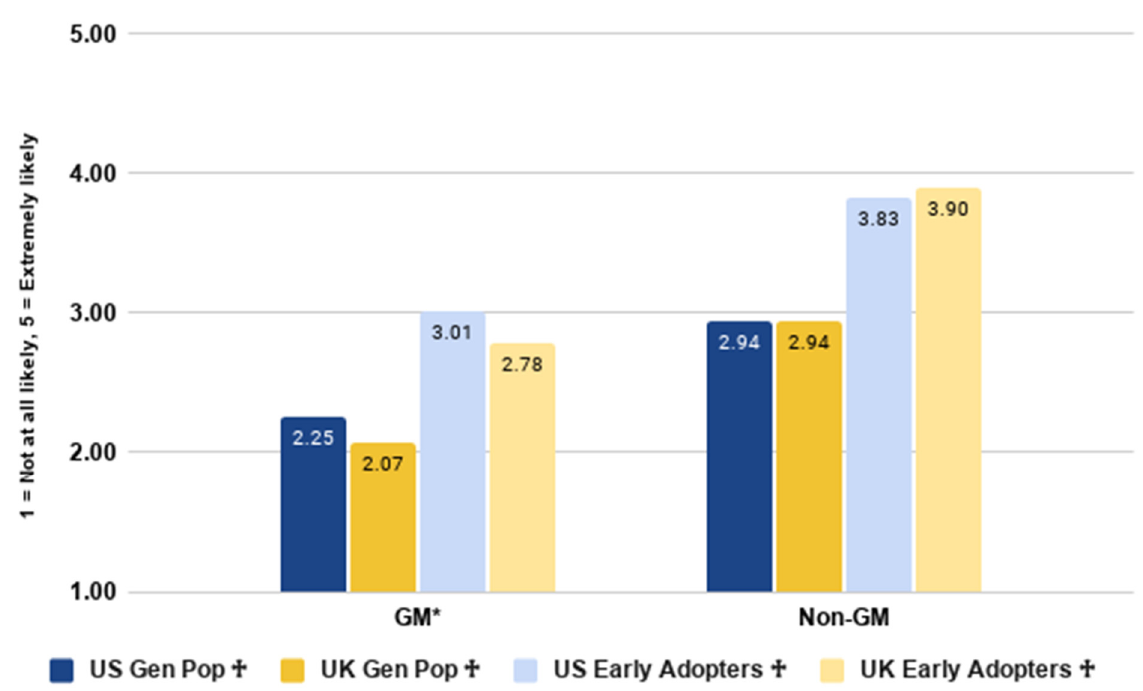
Figure 16. Likelihood of purchase GM and non-GM cultivated meat by country and segment. * indicates a significant difference in purchase intent between the two countries within the identified product. † indicates a significant difference in purchase intent between the two products within the identified country.